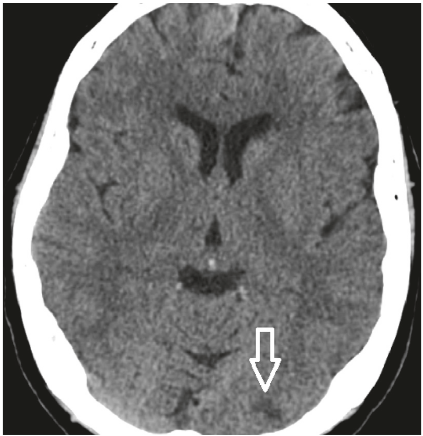
Figure 4: CT scan of the brain without contrast showing an infarct in the left occipital